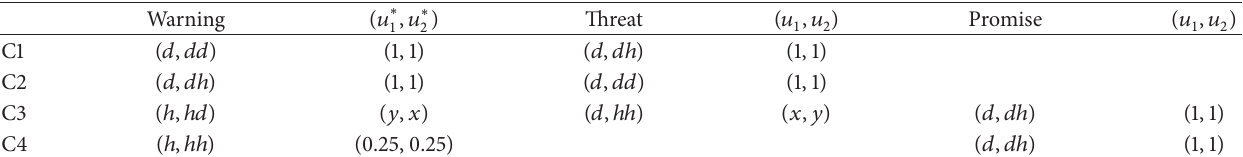
Table 5: Commitment